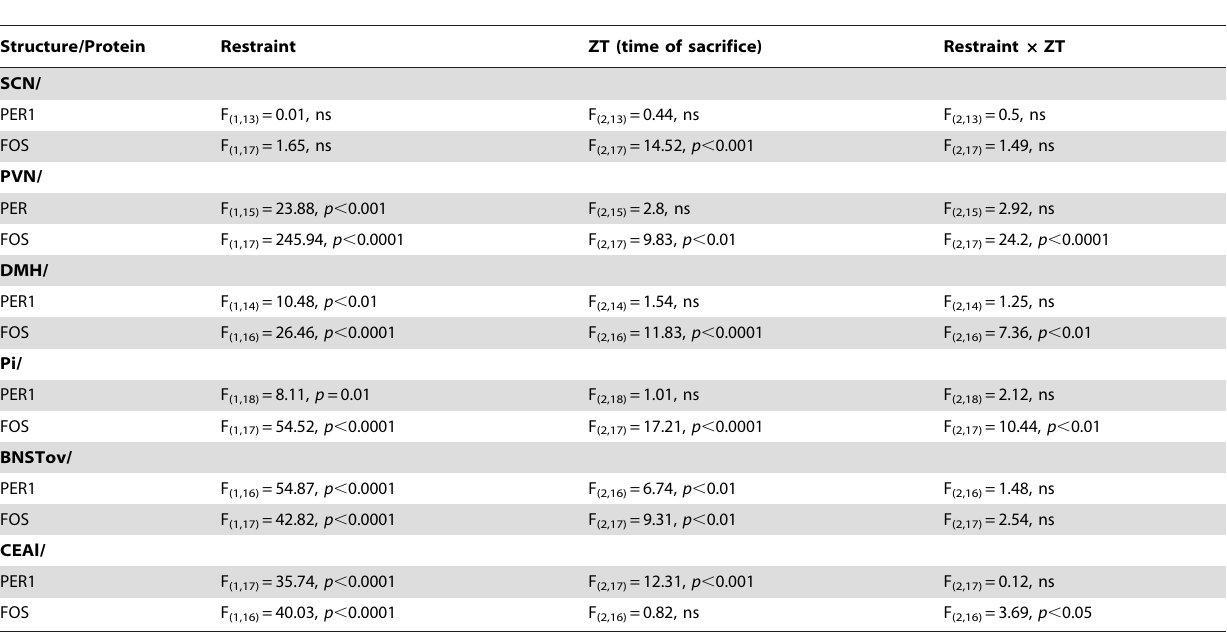
Table 1. Statistical analysis (ANOVA) of the effect of acute restraint stress on PER1 and FOS expression in hypothalamic and limbic brain